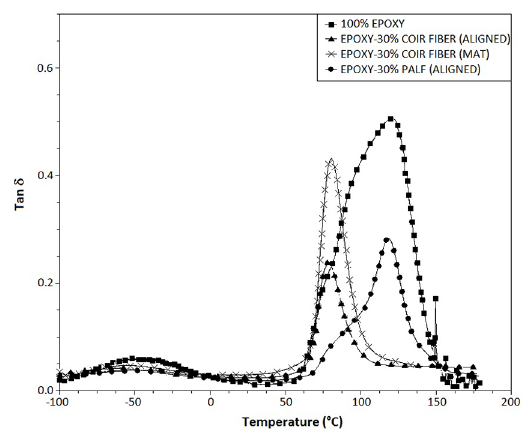
Figure 4. Effect of temperature on the tan δ curves of the composites reinforced with different fibers.